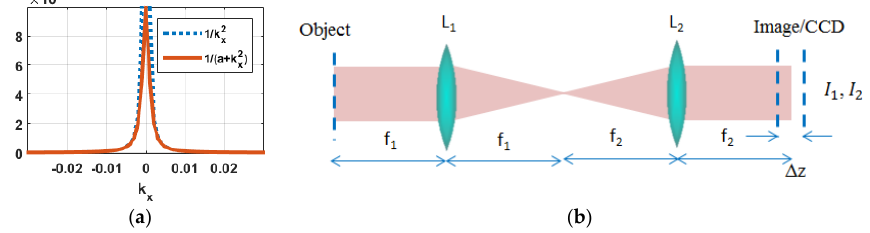
Figure 1. ( a ) Frequency plot showing the effect of regularization; ( b ) Schematic setup of a traditional TIE system. The 4 f TIE setup shows how the phase at the front focal plane of lens L 1 is relayed to the back focal plane of lens L 2 , and the two defocused planes I 1 and I 2 .